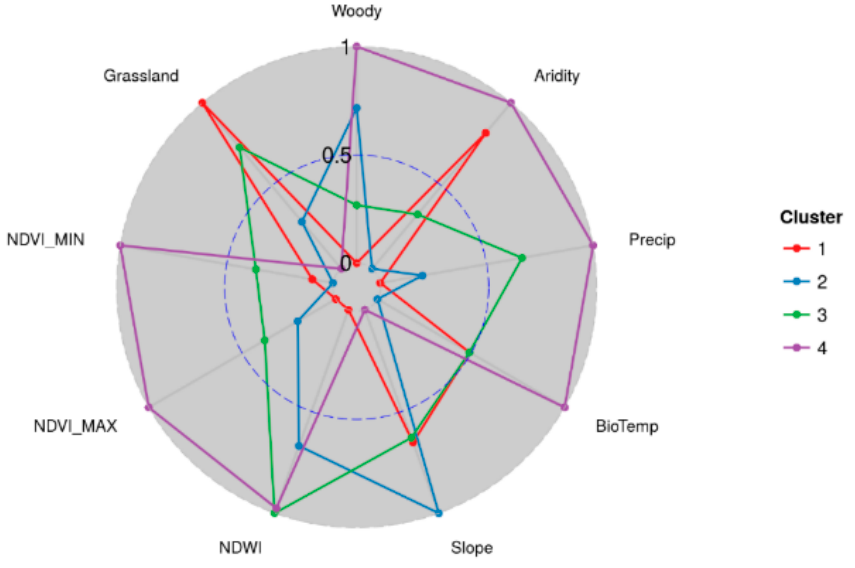
Figure 4. Normalized average values of the study variables in each HFT identified. Variables legend: percentage of tree (Woody) and grassland cover (Grassland), slope (Slope), aridity (Aridity), biotemperature (BioTemp), precipitation (Precip), Maximum and Minimum Normalized Difference Vegetation index (NDVI_MAX and NDVI_MIN, respectively) and Normalized Difference Water index (NDWI). Table 2. HFT detected inside the PA; LSR: Landscape Similarity Ratio value for each segment; Number of similar areas to each HFT found outside the PA. Area of each HFT inside the PA.